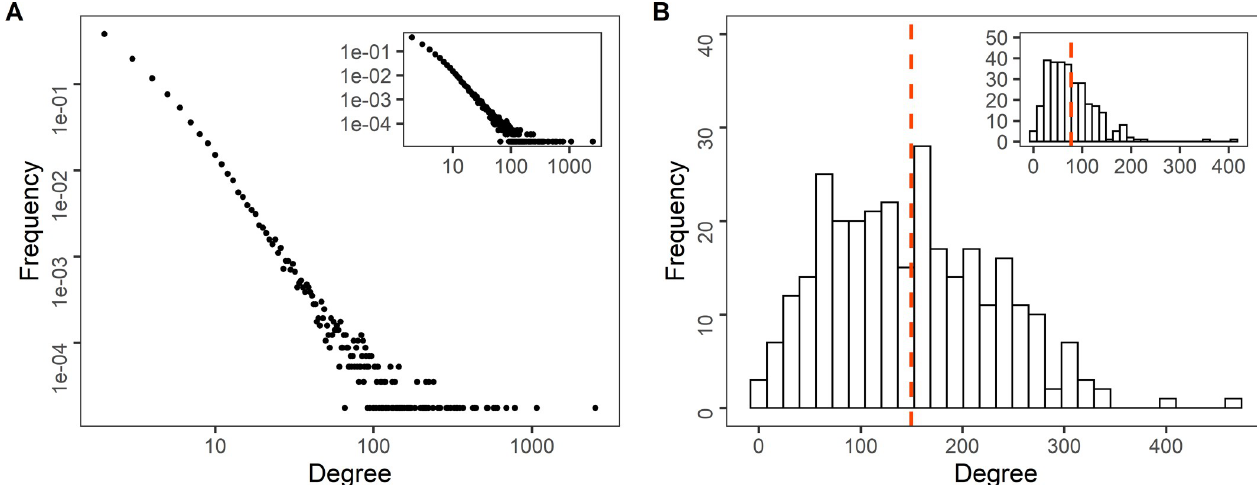
Fig 8. Degree distribution in a logarithmic scale for all cattle and cows in the global networks. (A) Holding level, (B) district level, all cattle (main graph) and cows (inset) (nodes and links were aggregated from 2014 to 2018).